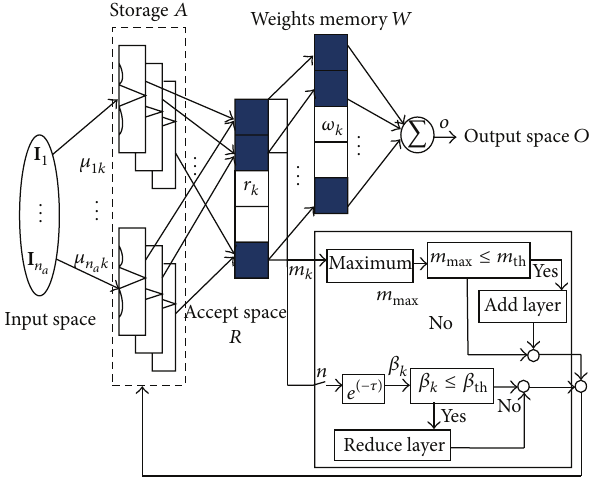
Figure 2: The structure of self-organizing wavelet CMAC neural